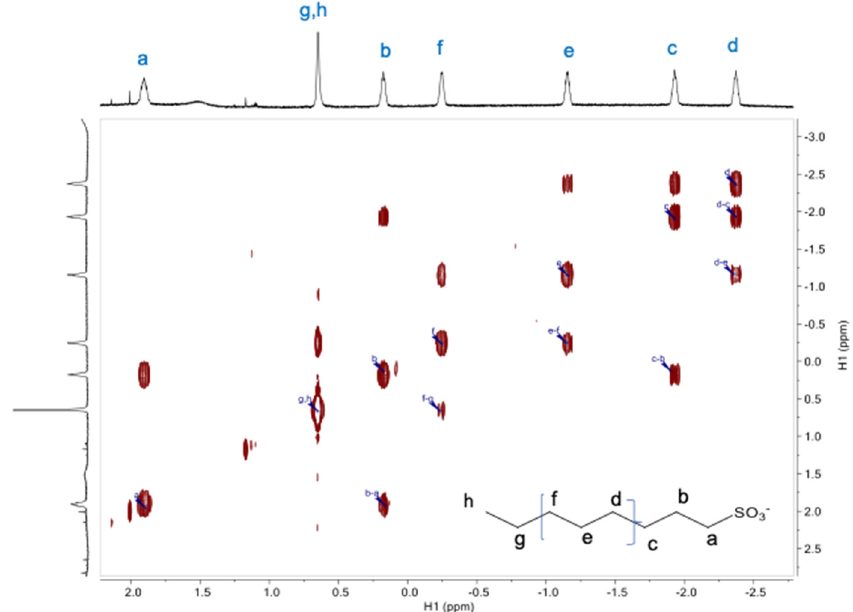
Figure 4. COSY spectra for a mixture of 1.5 mM of Pillararene and 0.5 mM of octylsulfonate in D 2 O a 25 °C. Labels for octylsulfonate hydrogen atoms are according to the picture shown in the figure. Assignment of NMR signals allows us to quantify the magnitude of the complexa- tion-induced upfield effect for each hydrogen atom in octylsulfonate (results showed in